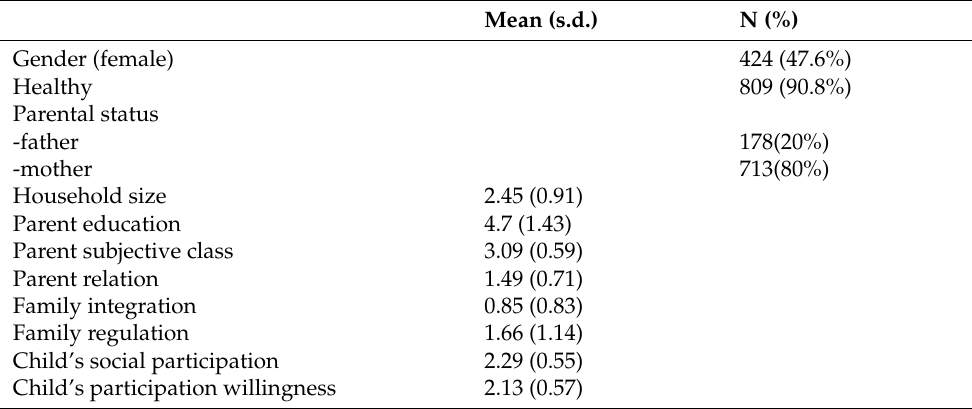
Table 1. Sample descriptive